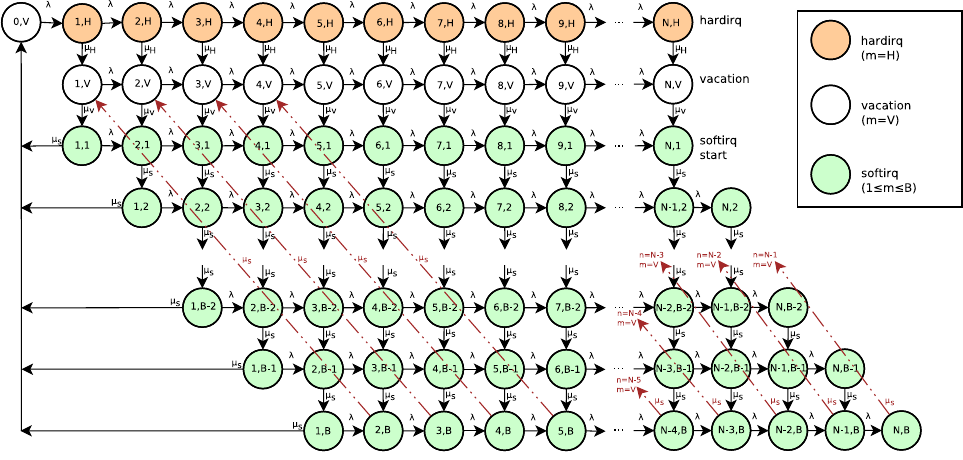
Figure 5. State-transition diagram of model